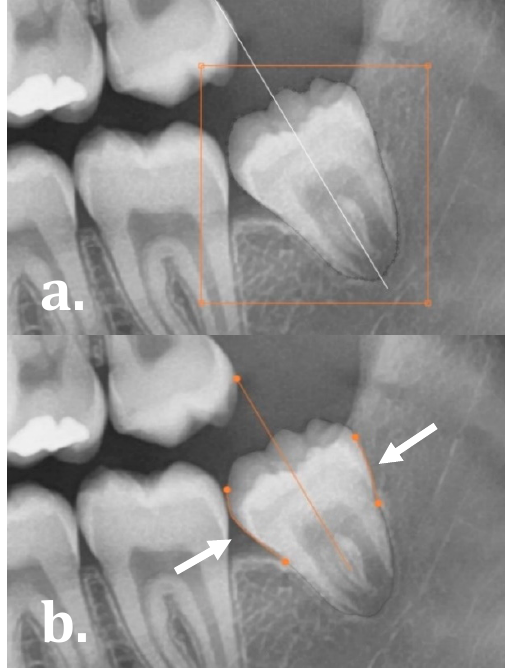
Figure 3. Manual adaptations to the network: ( a ) editing the segmentation map and ( b ) manipulating the orientation line by manually dragging the mesial and distal regression lines.